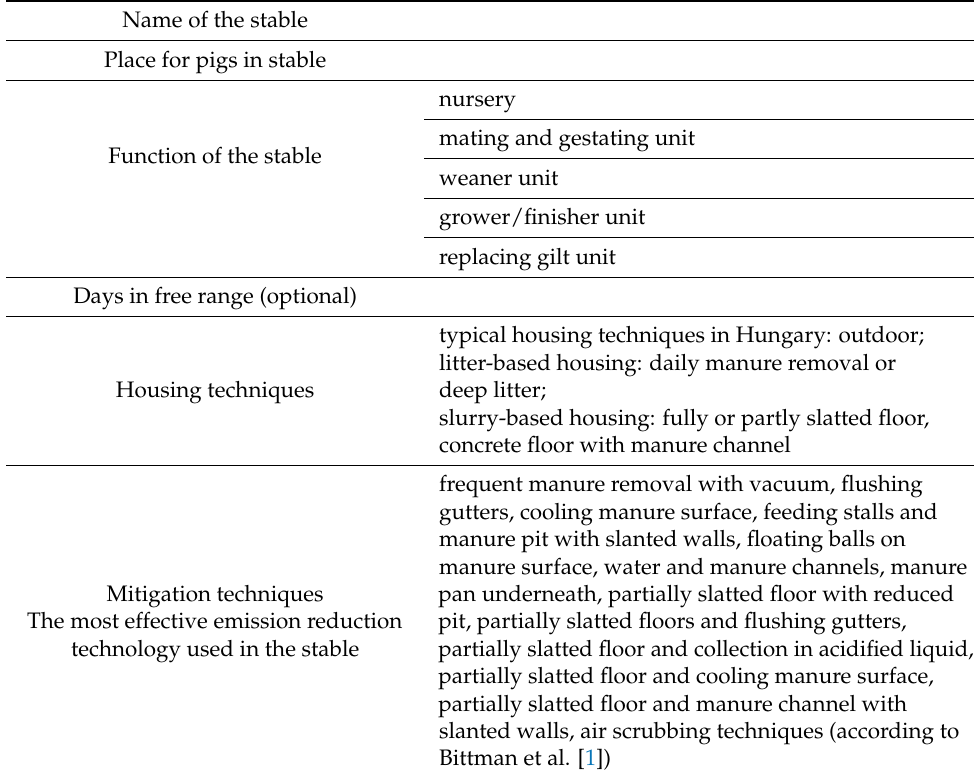
Table 3. The input data requirements of housing